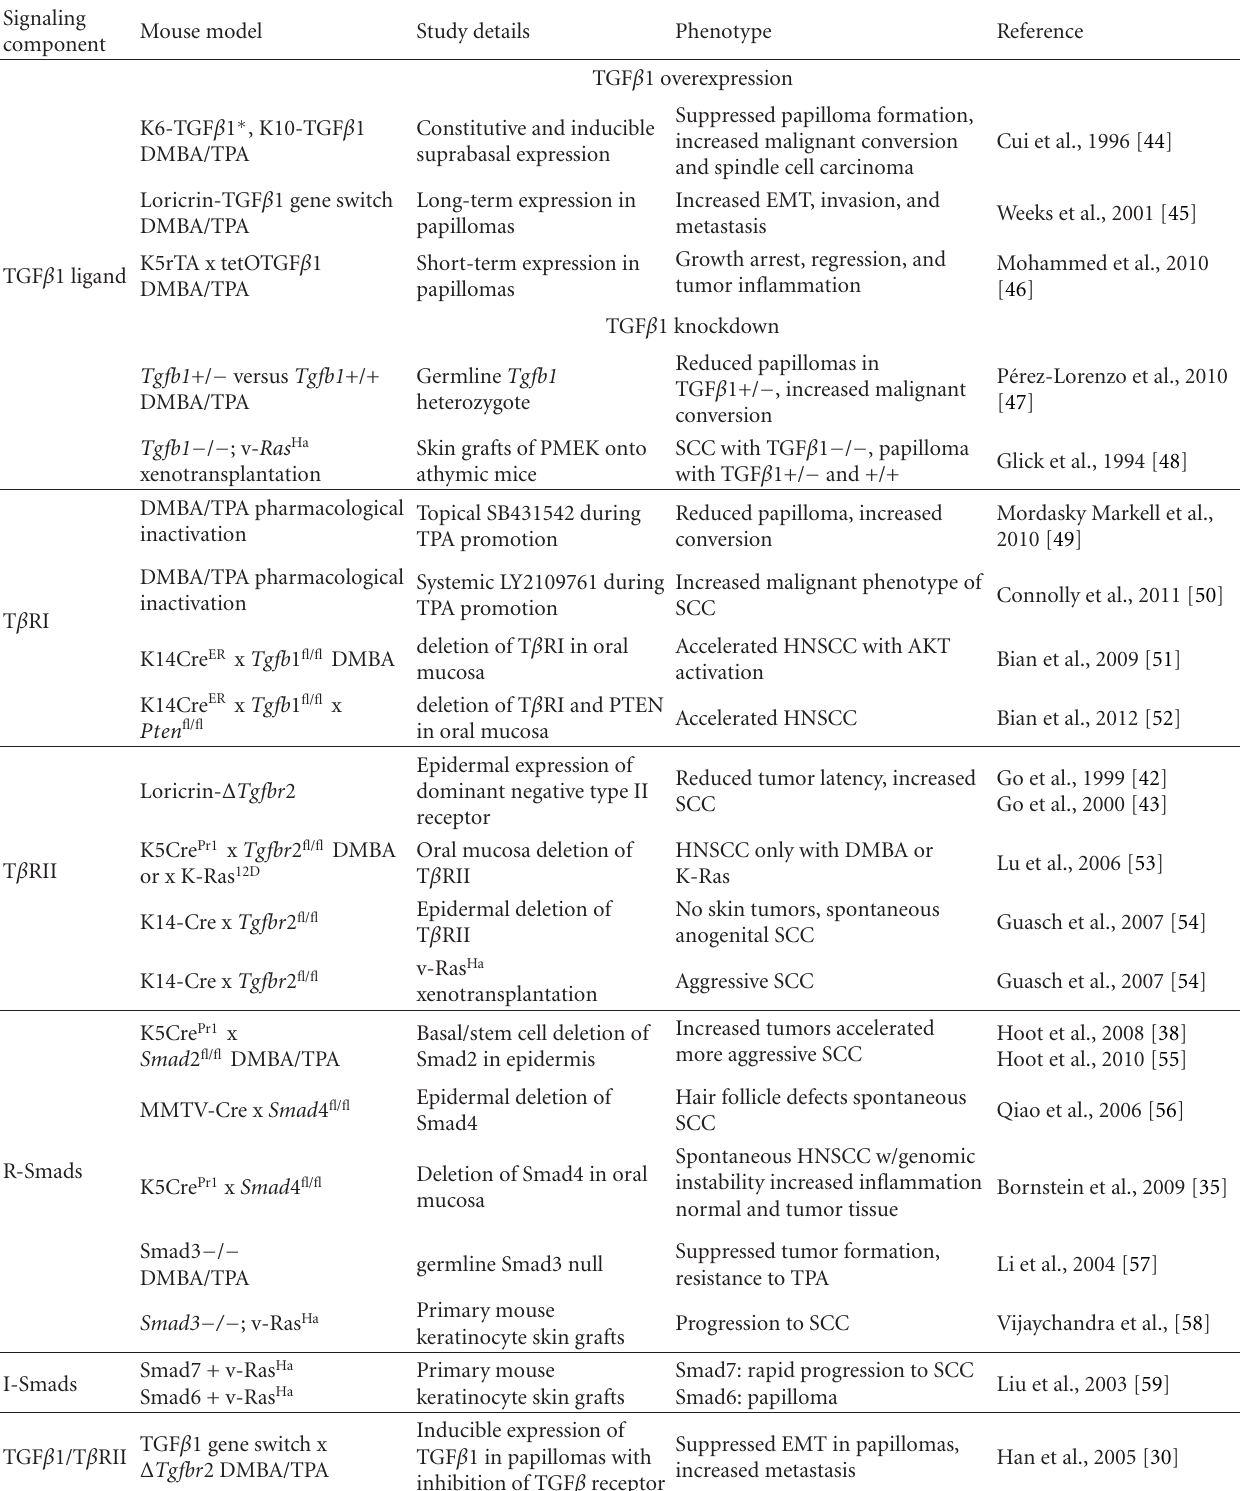
Table 1: Skin and oral carcinogenesis studies with mouse models of TGF β 1